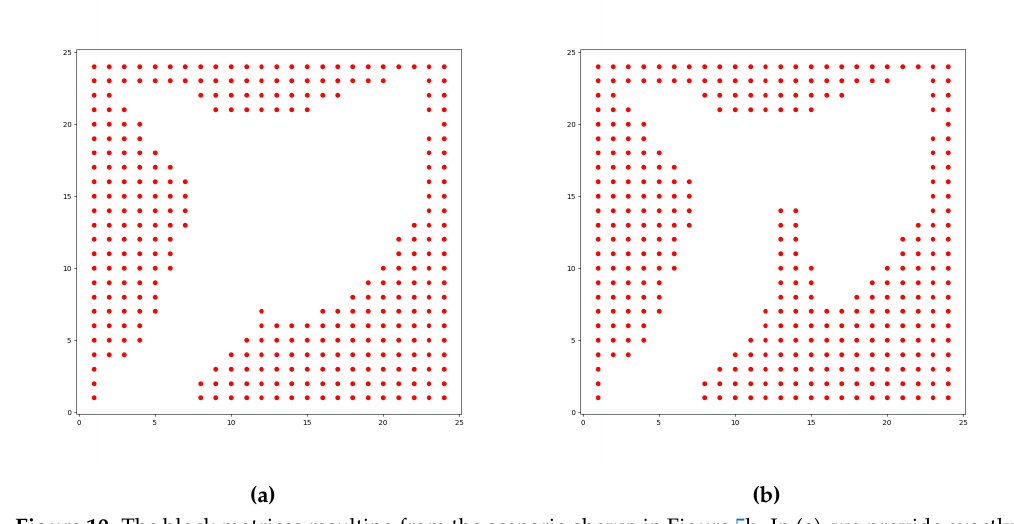
Figure 10. The block matrices resulting from the scenario shown in Figure 5b. In ( a ), we provide exactly the same map as already shown previously. In ( b ), there are some blocks added as obstacles to force the algorithm to change the trajectory